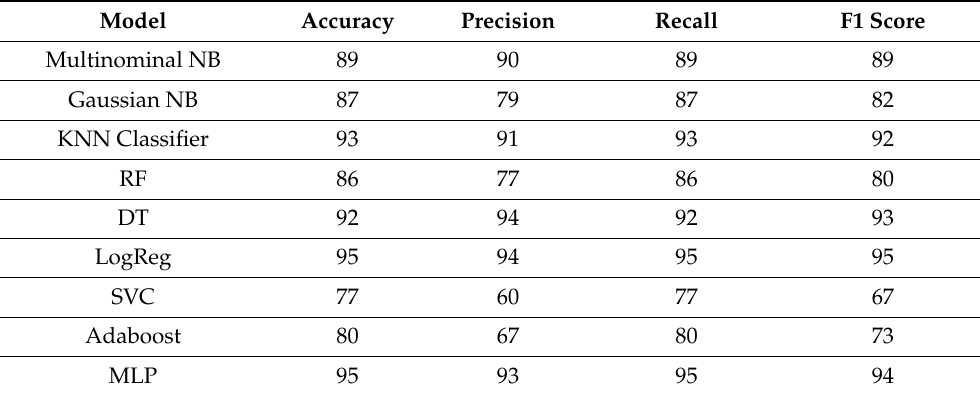
Table 3. Evaluation metrics scores for all ML